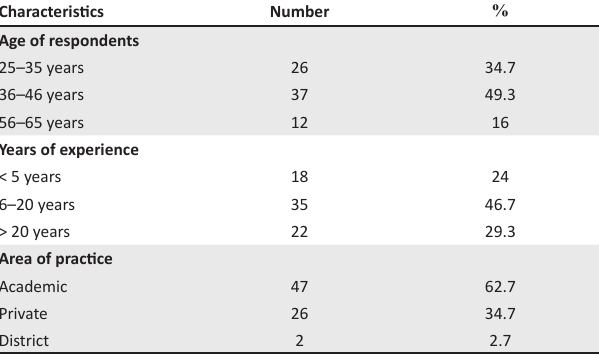
TABLE 1: Age, years of experience and area of practice of